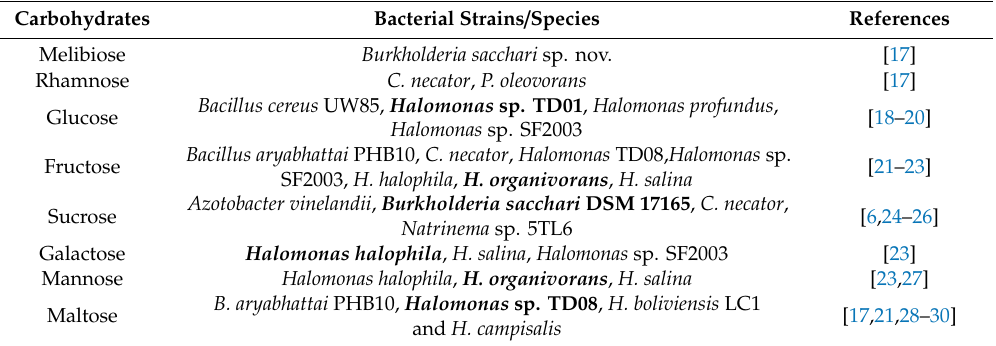
Table 4. Listing (not exhaustive) of various bacterial strains using the di ff erent tested carbohydrates for PHA